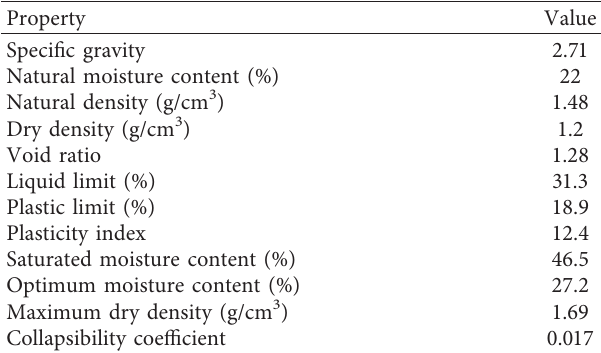
Table 1: Physical and mechanical properties of undisturbed loess.